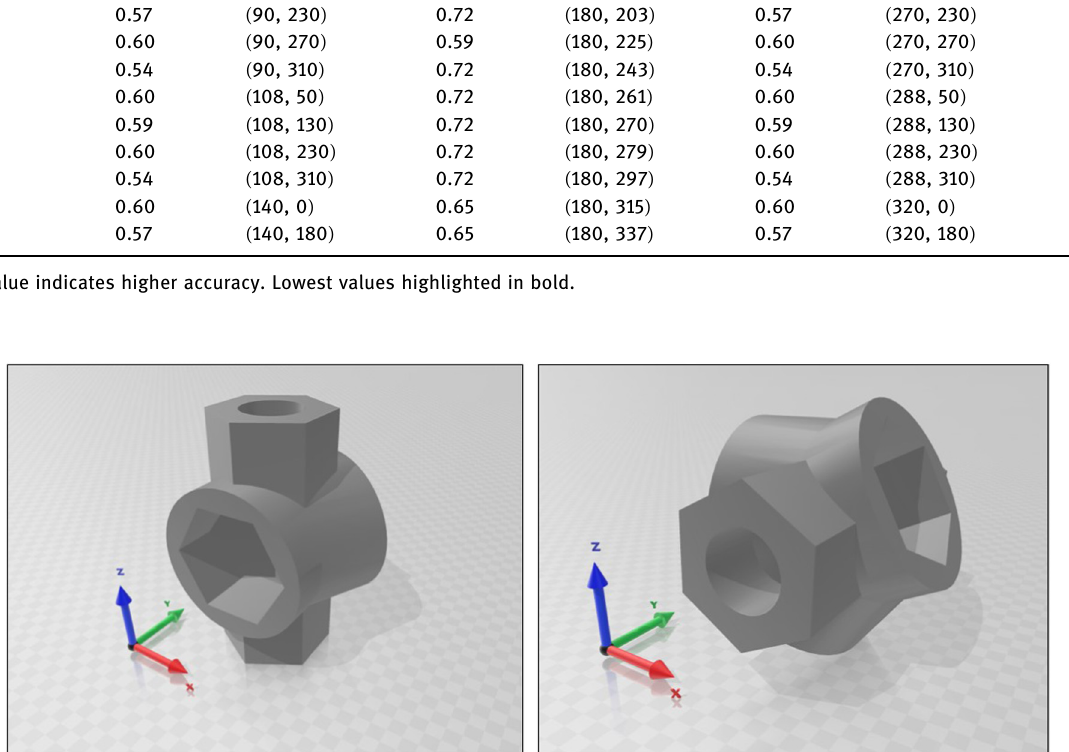
Figure 13: Optimal orientations identi fi ed for case 2. ( a ) Identi fi ed optimum ( 90 , 0 ∘ ∘ ) . ( b ) Alternative orientation ( 0 , 63 ∘ ∘ ) .